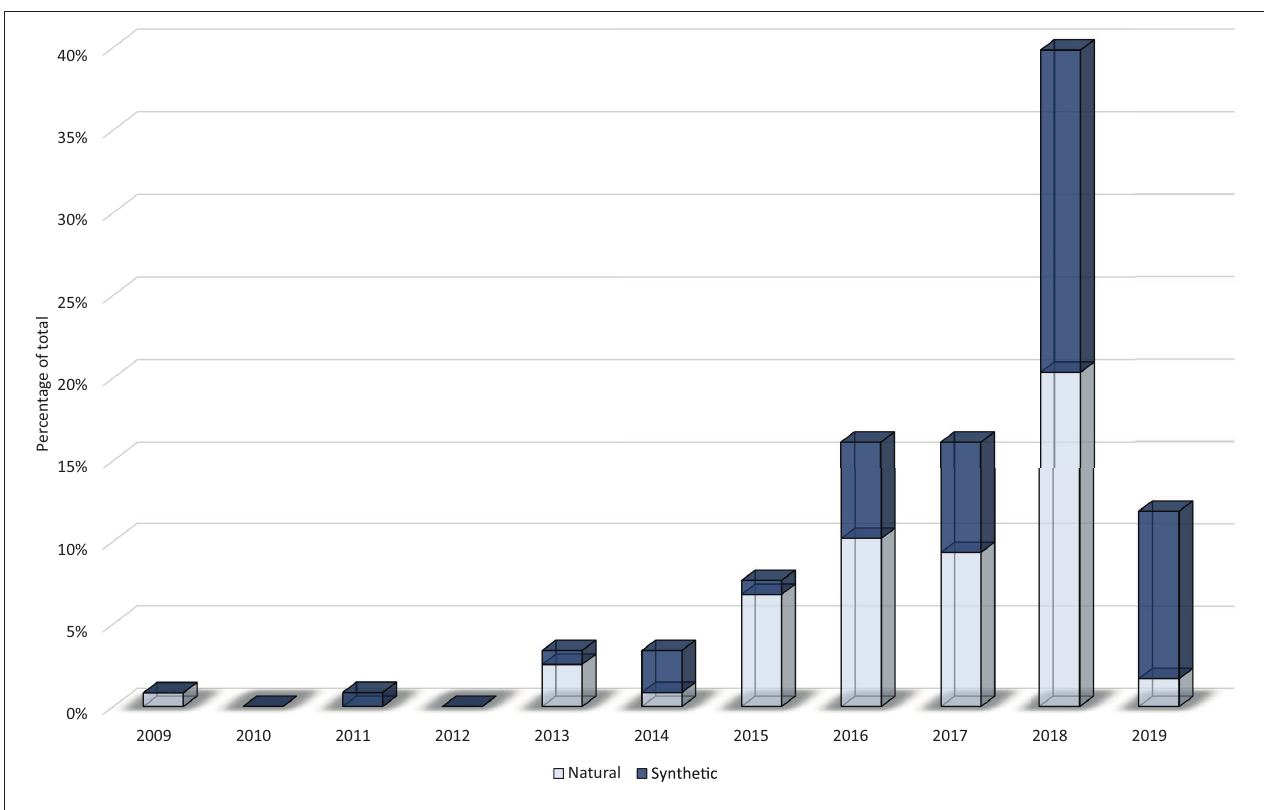
FIGURE 5 | Stacked columns graph that shows evolution per year of natural (white) and synthetic (blue) materials on the percentage of total.